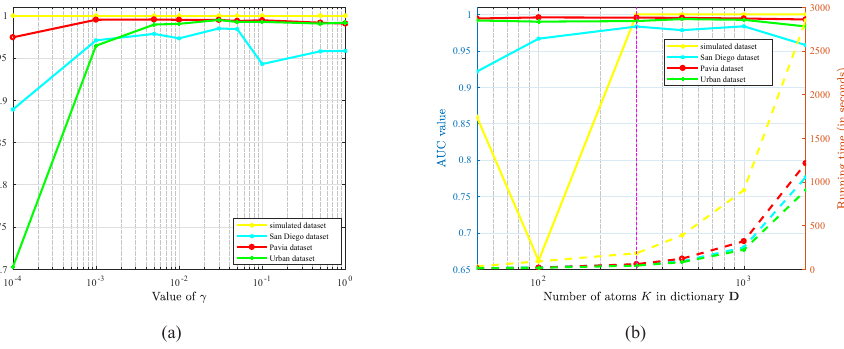
Figure 13. ( a ) The influence of parameter γ on the detection performance for four datasets. ( b ) The influence of parameter K on the detection performance and running time for four